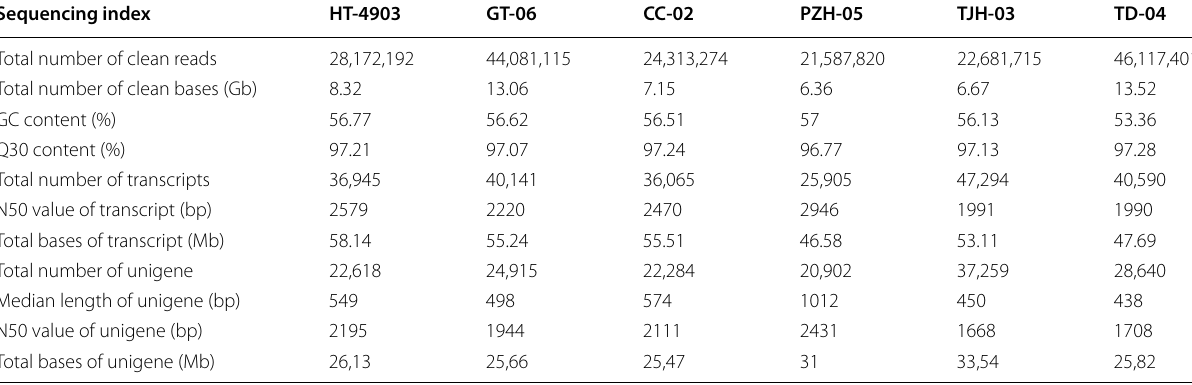
Table 1 Summary of the sequencing and assembly of six H. erinaceus strain samples Sequencing